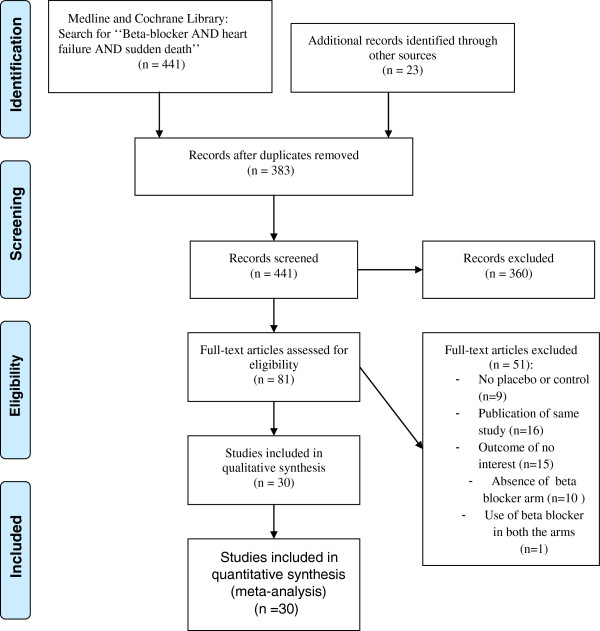
PRISMA flow diagram for the meta-analysis. Study selection process according to Preferred Reporting Items for Systematic Reviews and Meta-Analyses (PRISMA) guidelines.